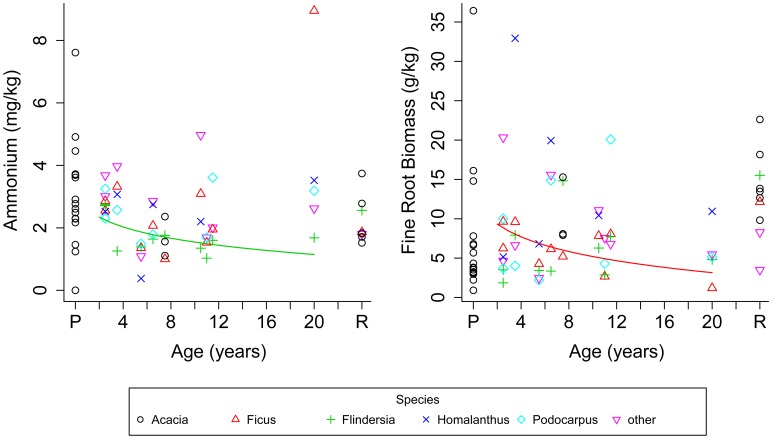
Differences in ammonium (left panel) and fine root biomass (right panel) over time under five tree species in pasture (P), reforestation sites aged 2 to 20 years, and remnant rainforest (R).Genus names refer to the selected tree species under which the soil samples were taken. “Other” refers to soil samples taken from non-specified tree species or pastoral sites. Lines show fitted values of the modeled relationship between individual soil properties and log-transformed age for species with significant models - Flindersia schottiana (a) and Ficus coronata (b).